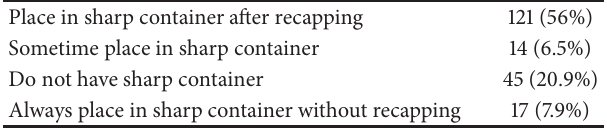
Table 6: What do you do with used syringe and